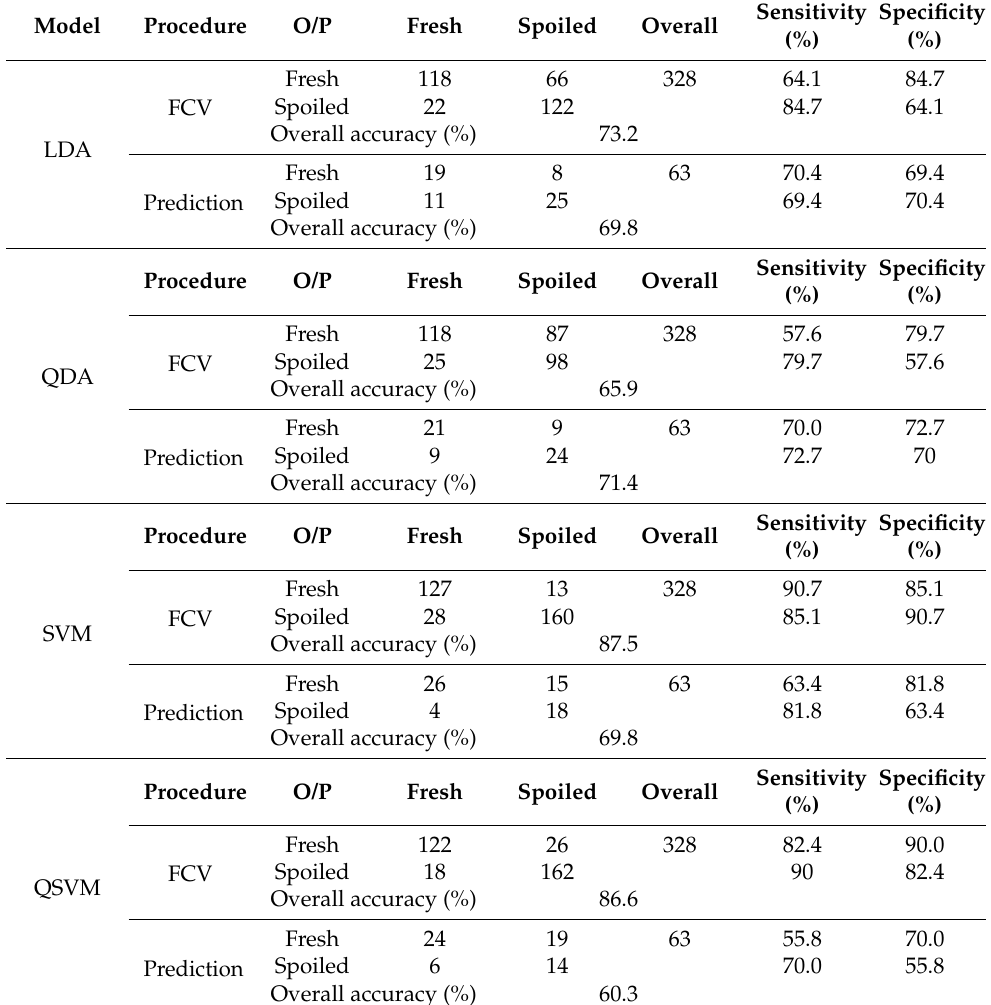
Table 5. Confusion matrix and performance indexes of the developed classification models (LDA, QDA, SVM, QSVM) regarding sensory quality discrimination of chicken thigh samples based on FT-IR spectral